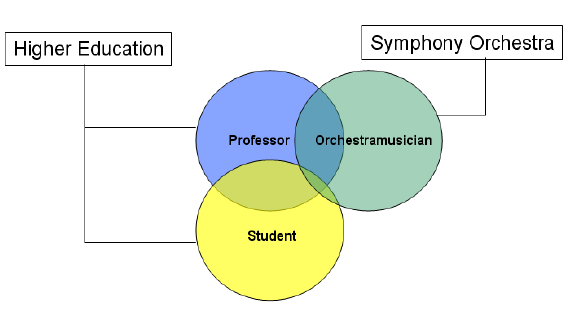
2 | Fig. 2: Field of Research and